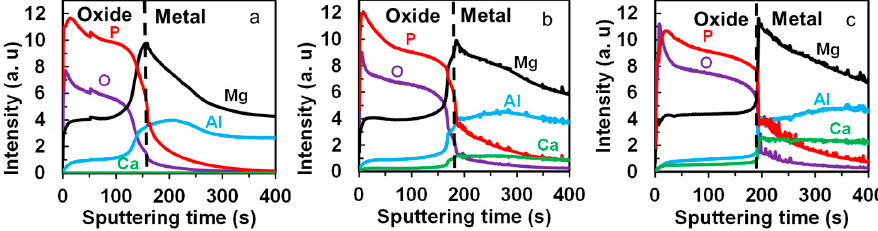
Figure 7. Glow-discharge optical emission spectroscopy (GDOES) elemental depth profiles of PEO films formed on ( a ) AM60; ( b ) AM60-1Ca; and ( c ) AM60-2Ca specimens after 20 min of anodization in 0.5 mol·dm − 3 Na 3 PO 4 solution at 25 °C.